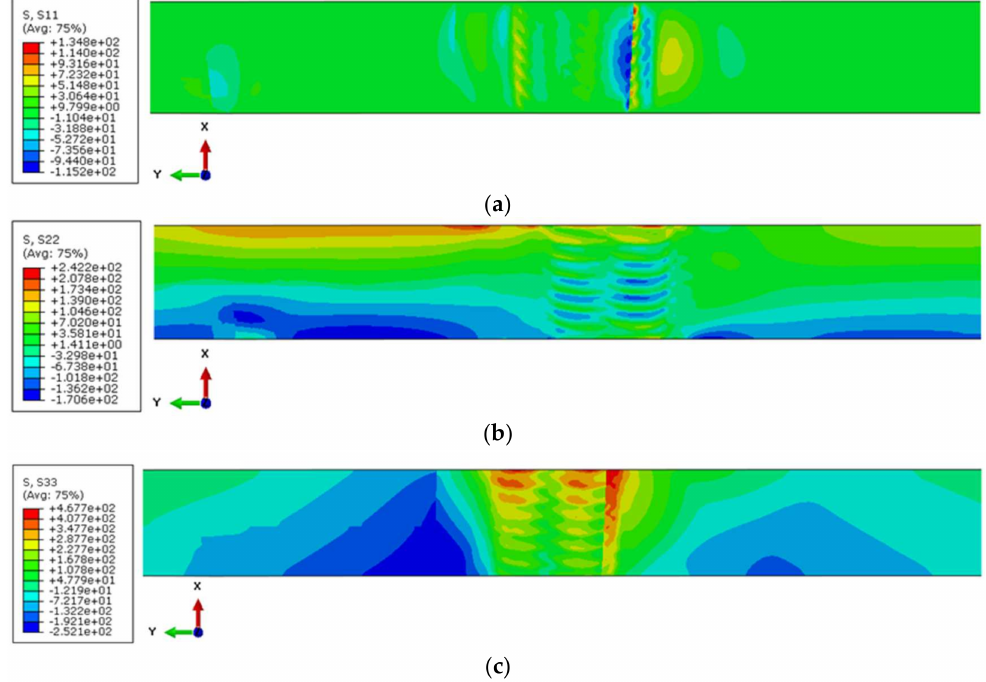
Figure 11. FE prediction of the radial ( a ), axial ( b ) and hoop ( c ) residual stress (MPa) distributions in the DMW joint after